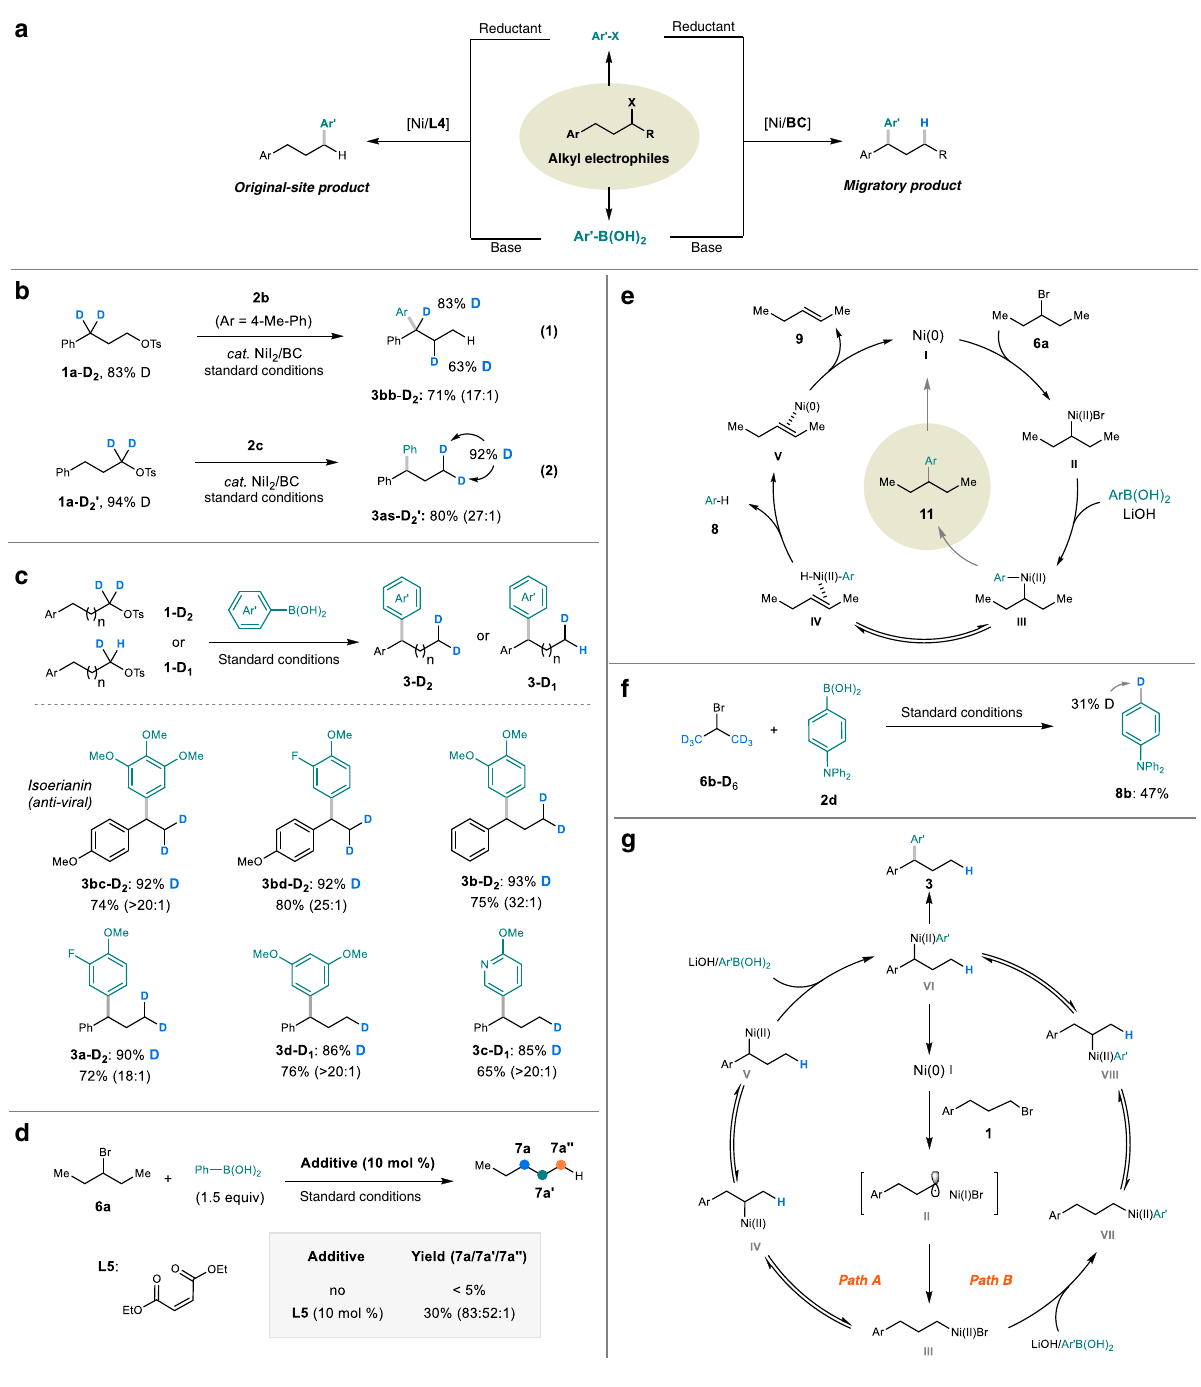
Fig. 4 Mechanism discussion. a Ni-catalyzed migratory cross-coupling of alkyl electrophiles with aryl coupling partners. b Experiments of D-labeled alkyl bromide with aryl group. c Synthesis of terminal D-labeled molecules. d Investigation the role of aryl group. e Proposed mechanism of D-labeled alkyl bromide without aryl group. f Experiments of D-labeled alkyl bromide without aryl group. g Proposed